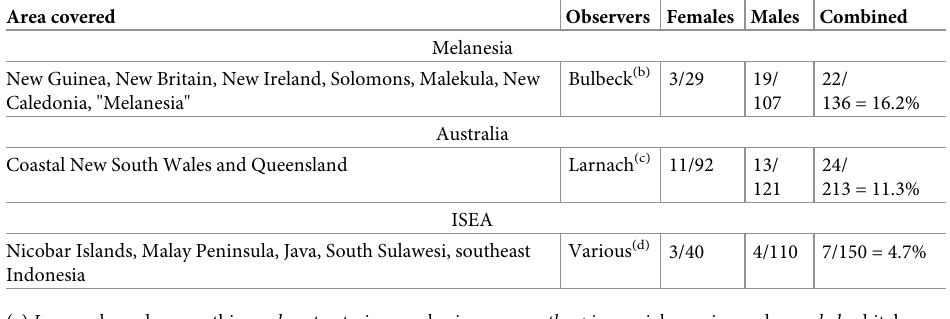
Table 6. Recent (2000 BP and less) Indo-Pacific crania with Maros-LBB-1a cranial morphology (a) . ISEA = Island Southeast Asia. Area